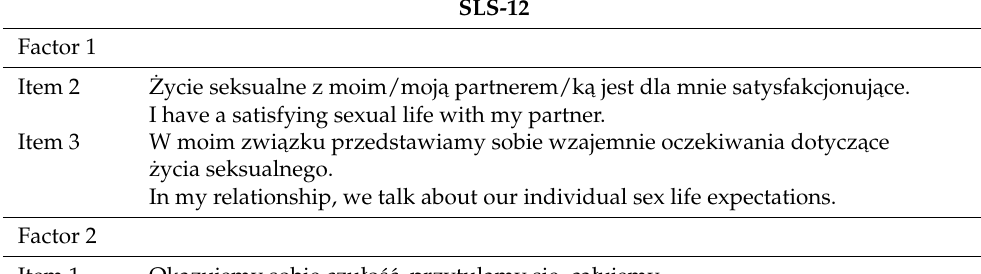
Table A1. W jakim stopniu poni˙zsze stwierdzenia odnosz ˛a si˛e do Pana/Pani stałego zwi ˛azku?